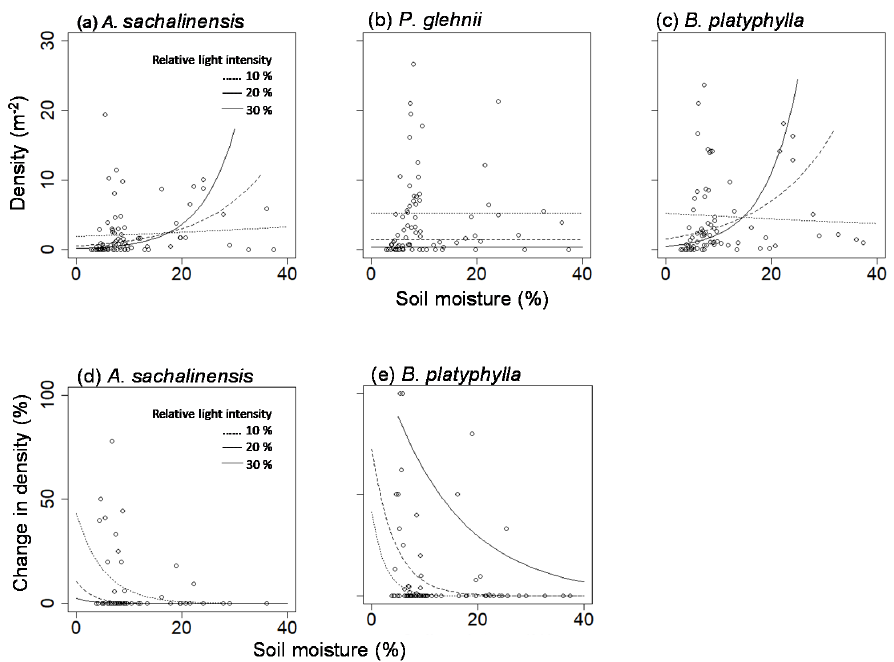
Figure 1. Seedling density at the 2-nd growing season( a – c ), and change in the density during 2-nd and 10-th growing seasons ( d – e ) in relation to the light intensity and the soil moisture content. The lines are drown based on the results of the generalized linear models (Table 4).